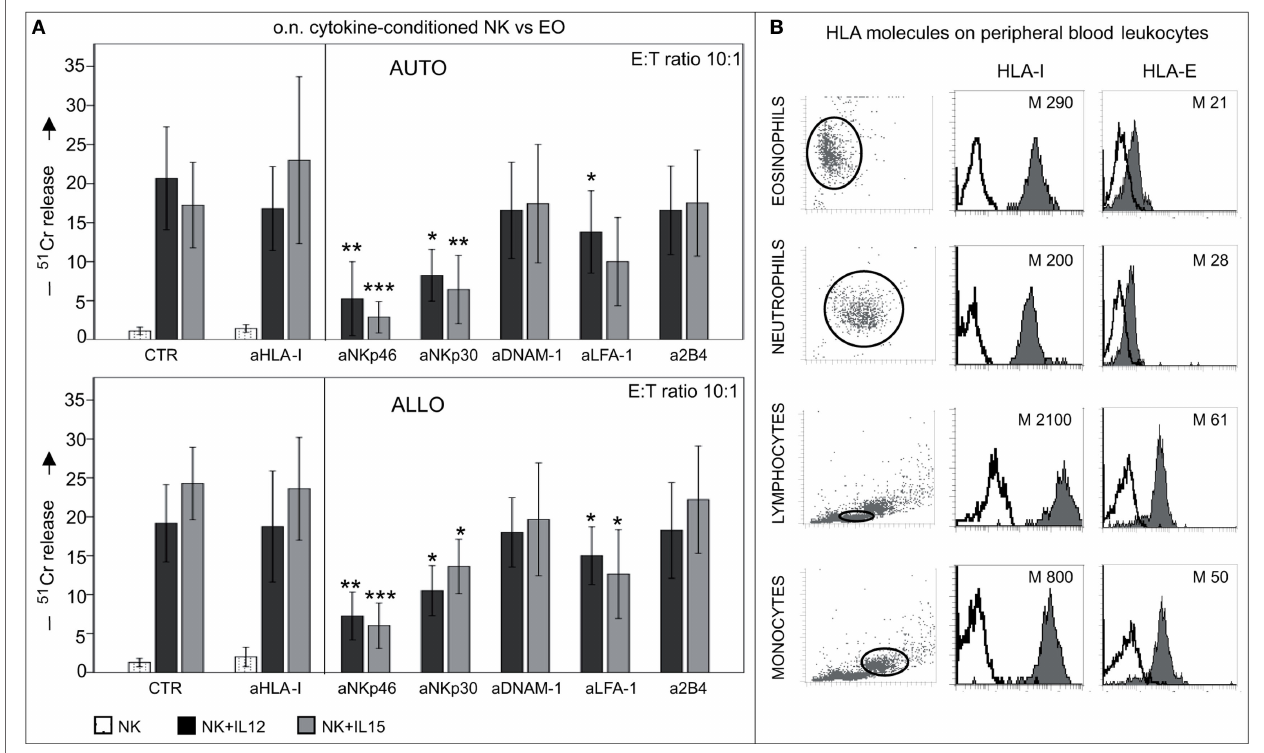
FigUre 8 | cytolytic activity of short-term-conditioned nK cells against autologous (aUTO) or allogeneic (allO) eosinophils (eO) . (a) NK cells were cultured o.n. with or without IL12 or IL15 and then tested in 51 Cr-release assay against autologous (upper panel) or allogeneic (lower panel) EOs. The cytolytic activity was tested in the absence or in the presence of the indicated blocking mAbs at an E : T ratio of 10:1. White bars refer to lysis by resting NK cells, black bars represent lysis by IL12-conditioned NK cells, gray bars refer to lysis by IL15-conditioned NK cells. The average of eight independent experiments is shown (% ± SD). * P < 0.05; ** P < 0.01; *** P < 0.001. P value was obtained by comparing the conditions NK + IL12 (black bars) or NK + IL15 (gray bars) in the presence of the different mAbs with the same conditions in the absence of mAbs (CTR). (B) Different leukocyte populations derived from peripheral blood of healthy donors were analyzed for surface expression of HLA-I and HLA-E molecules (median values are indicated). A representative donor out of 15 is